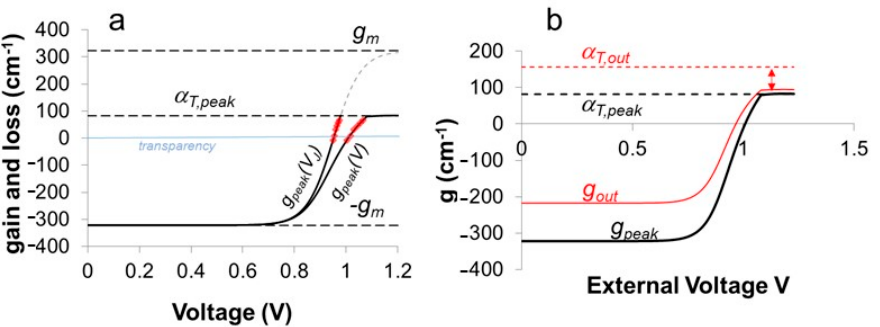
Figure 11. ( a ) Gain at the DFB peak as a function of both the internal voltage V J and the external voltage V; ( b ) gain and loss measured at the DFB peak and at a different emission line (suffix “out”), as functions of the external voltage V.